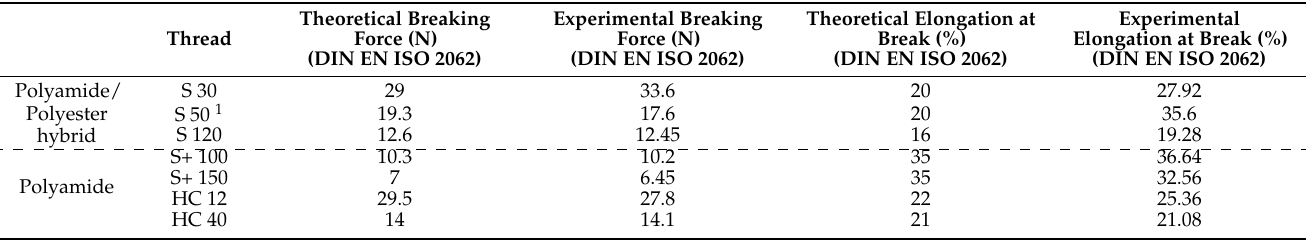
Table 3. Comparison of theoretical versus tested values for maximum force at break and percentage of elongation at break for all tested threads.